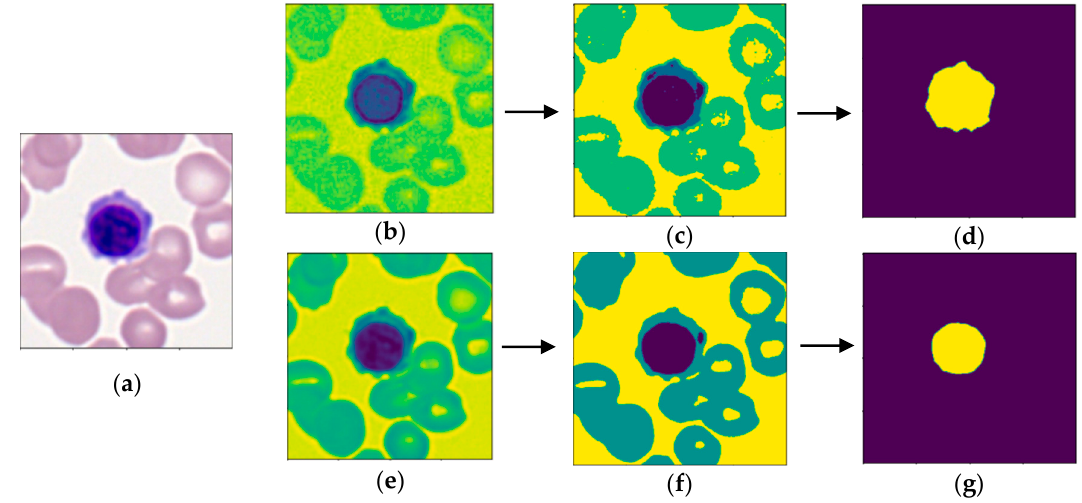
Figure 2. Sample of segmentation process. Images ( b ) to ( d ) display segmentation of the cell, while images ( e ) to ( g ) show segmentation of the nucleus. ( a ) Raw image of an erythroblast [20,21]; ( b ) conversion to LAB color space; ( c) multi-Otsu thresholding; ( d) binary mask of cell; ( e ) conversion to grayscale format; ( f ) multi-Otsu thresholding; ( g ) binary mask of nucleus.